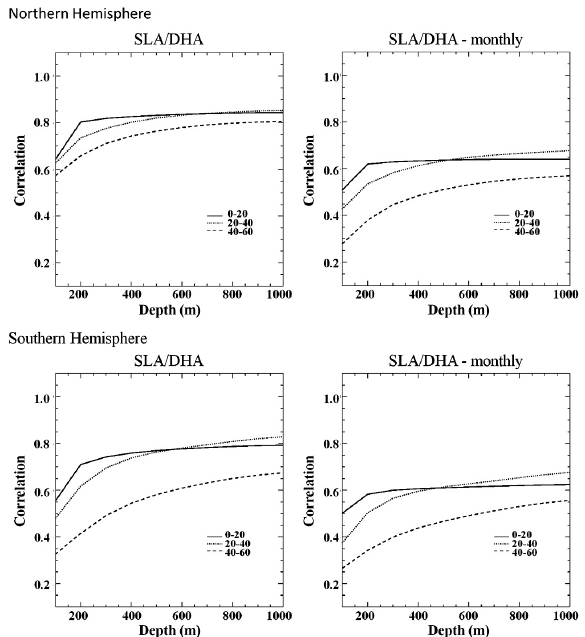
Fig. 6. Correlation between SLA and DHA by latitude bands as a function of depth used to calculated DHA, for the Northern Hemi- sphere (top) and the Southern Hemisphere (bottom) and for to- tal SLA/DHA (left) and for SLA/DHA filtered from the seasonal